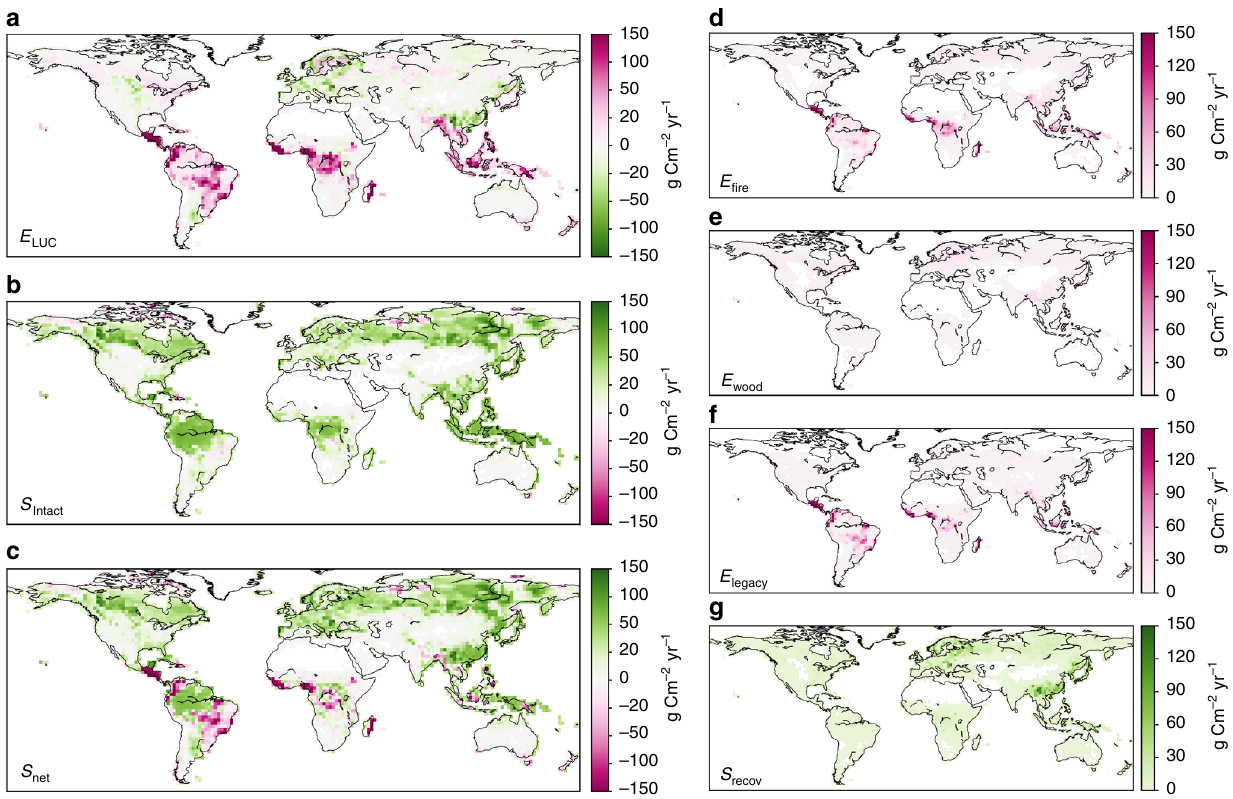
Fig. 2 Land – atmosphere carbon fl uxes over managed and intact lands. The annual mean values for 1990 – 2015 were shown. a E LUC over managed land. b S Intact . c S net . The further disaggregation of E LUC into its component emission fl uxes of E fi re , E wood , and E legacy , and the sink fl ux of S recov are shown in d – g ,